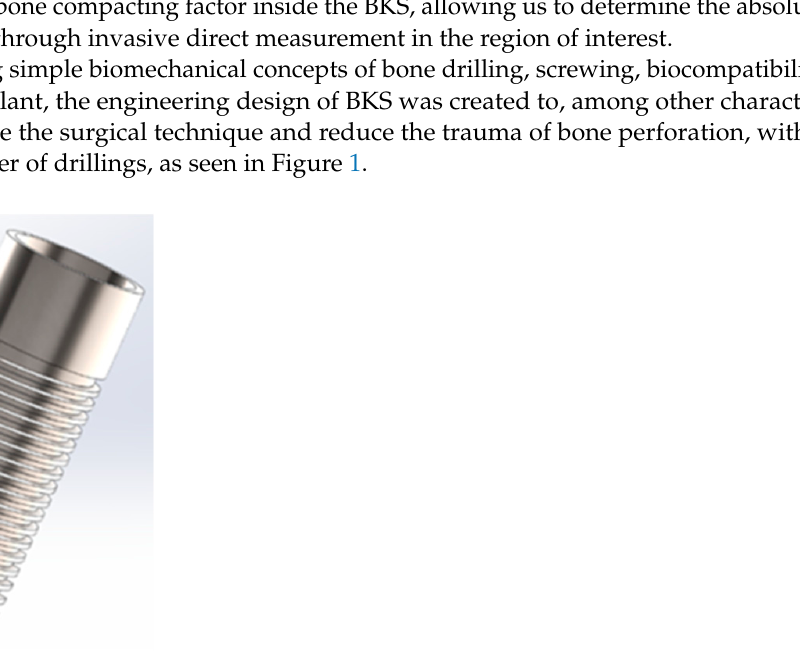
Figure 1. BKS as a dental implant applied in the Finite Element Analysis drilling and screwing into the bone simultaneously.